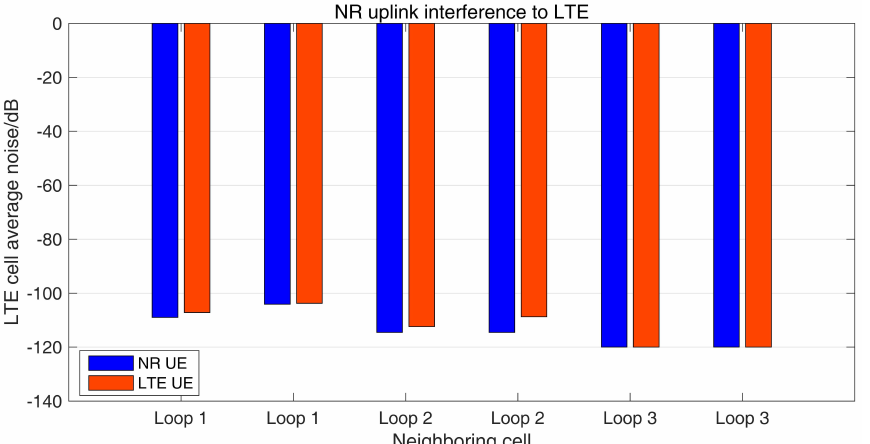
Figure 16. NR terminal to LTE uplink interference test